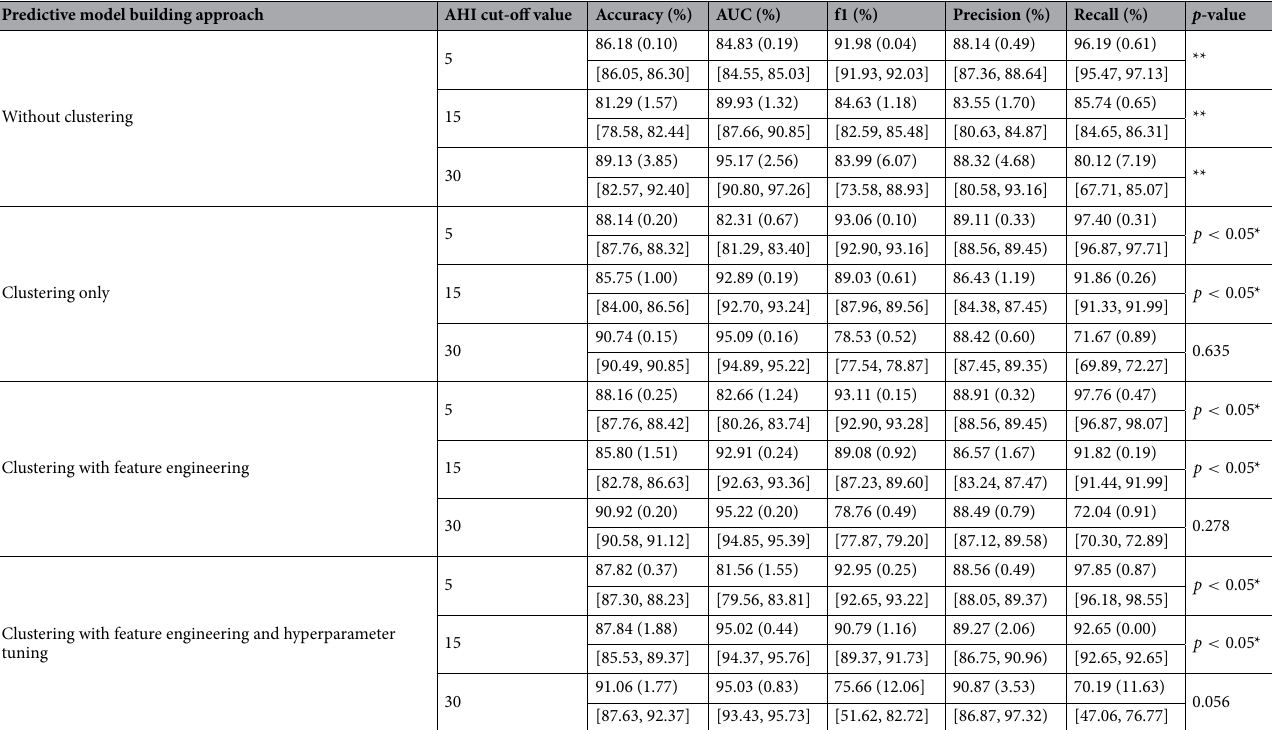
Table 2. The report of classification metrics of predictive models by approaches. Data are reported as mean (standard deviation) and [score range]. * p < 0.05 was statistically significant. ** Accuracies of the results were statistically tested and the classification results without clustering were used as the baseline for the statistical test (Mann-Whitney U